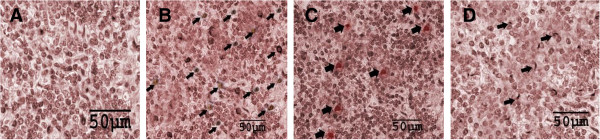
Immunohistochemical expression pattern of Bax in mid brain. A: Control (group 1); B: MPTP induced (group II); C: MPTP induced + As treated (group III); D: Drug Control (group IV).